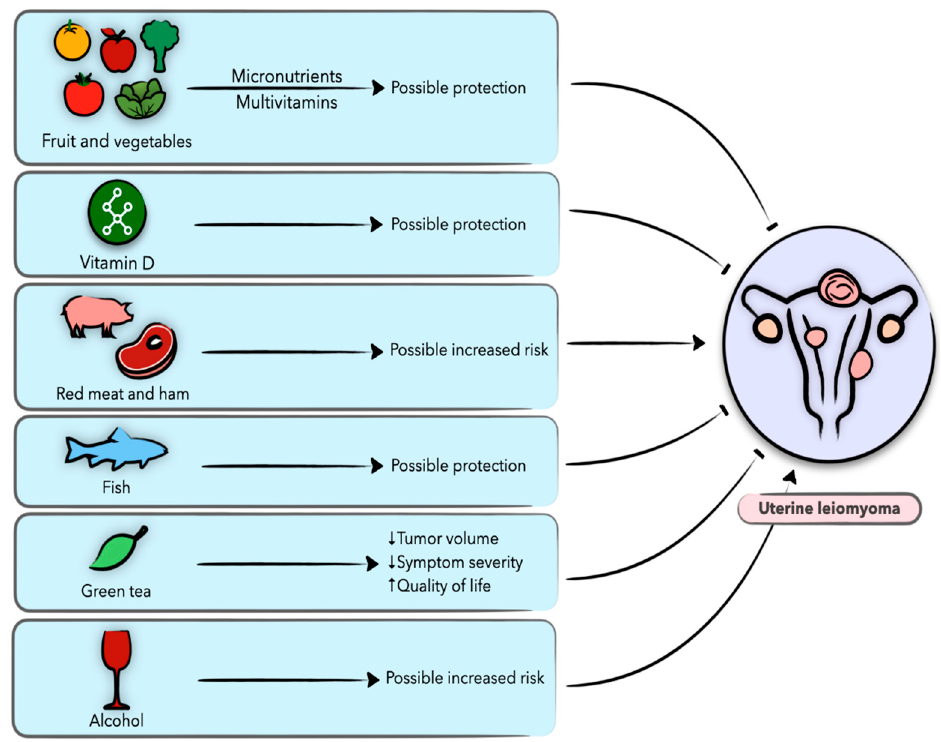
Figure 1. Schematic presentation of the role of diet and nutrition in uterine leiomyoma and the possible underlying biological mechanisms. possible underlying biological